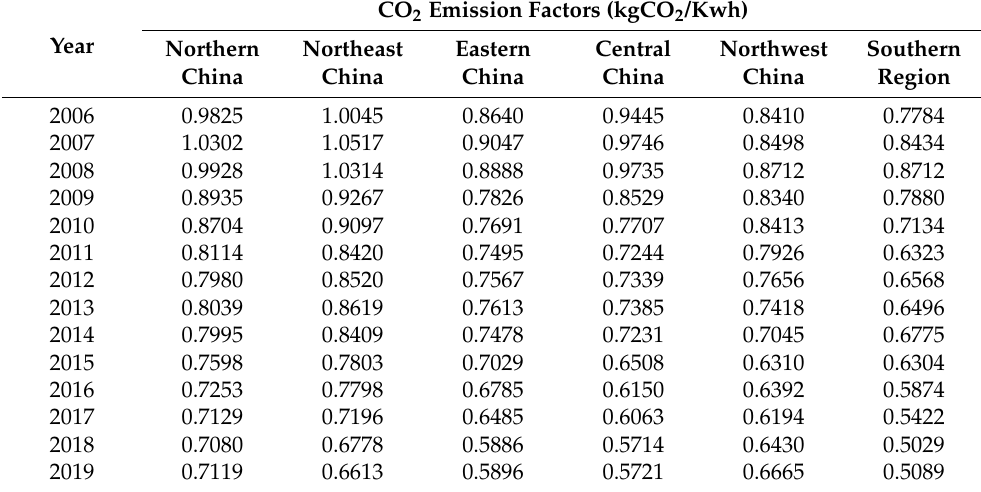
Table 6. CO 2 emission factors of each regional grid from